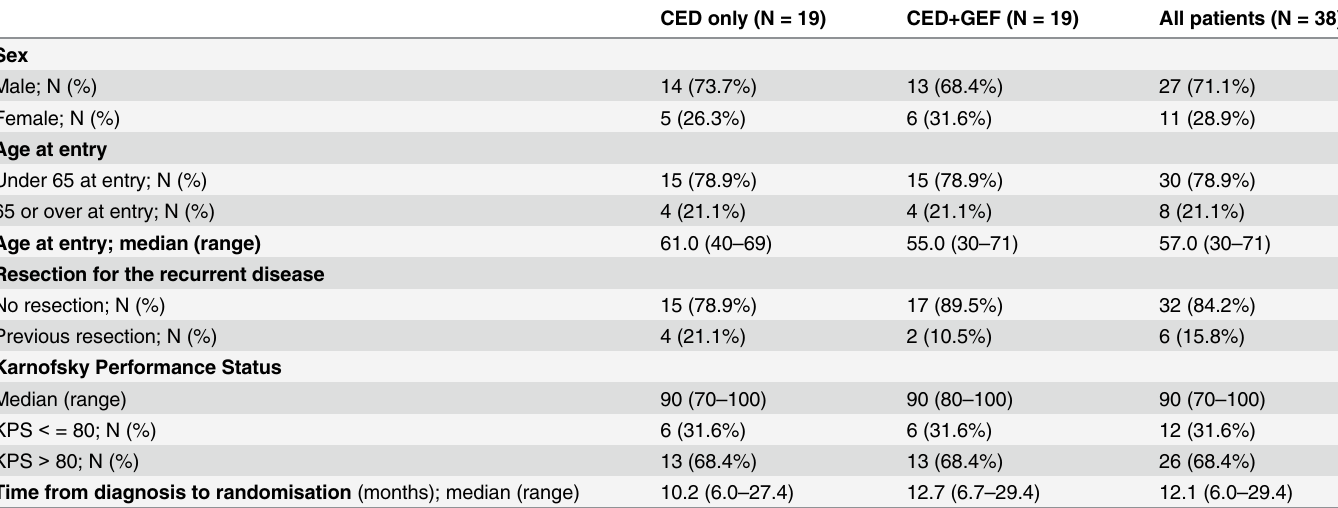
Table 1. Patient characteristics at baseline for the ITT